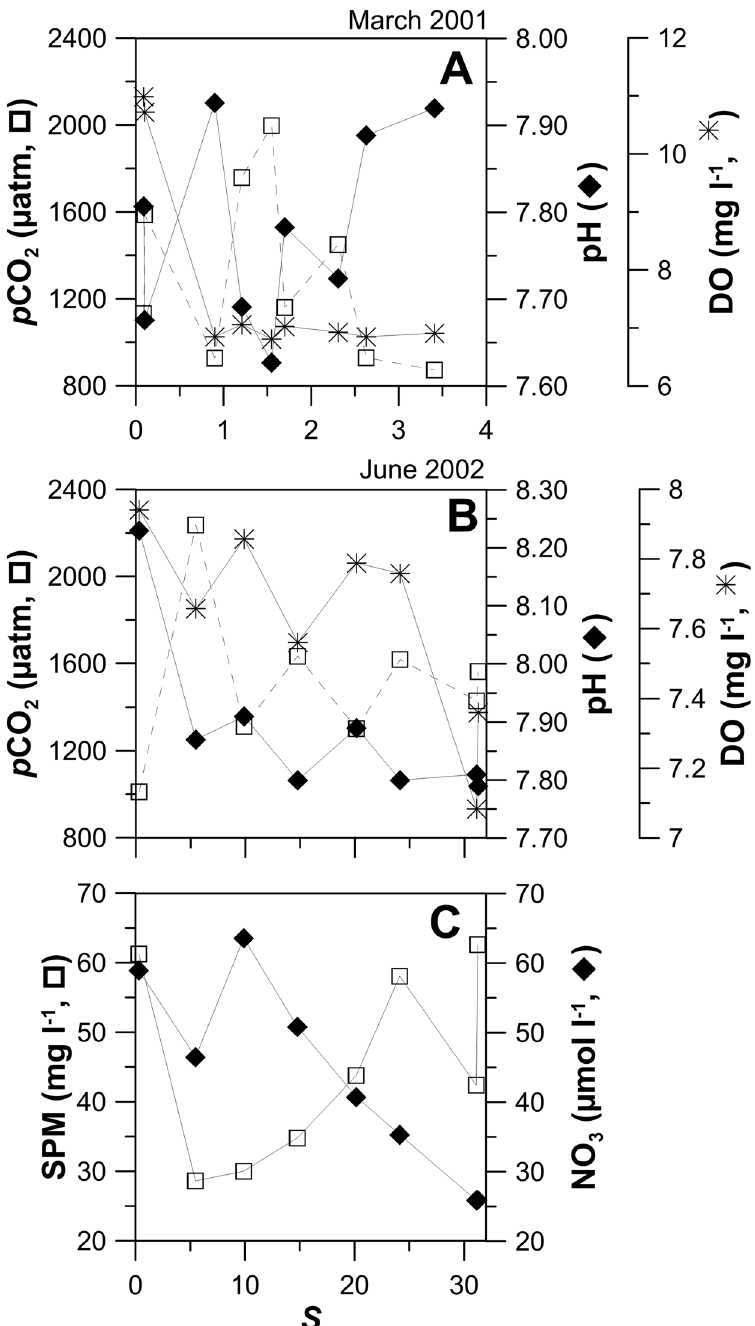
Figure 7. Distributions of CO 2 partial pressure ( p CO 2 ), pH and dissolved oxygen (DO) along the salinity gradient in ( A ) March 2001 and in ( B ) June 2002. Also, distributions of ( C ) suspended particulate matter (SPM) and nitrate (NO 3 ) in June 2002 along the salinity gradient in Tagus